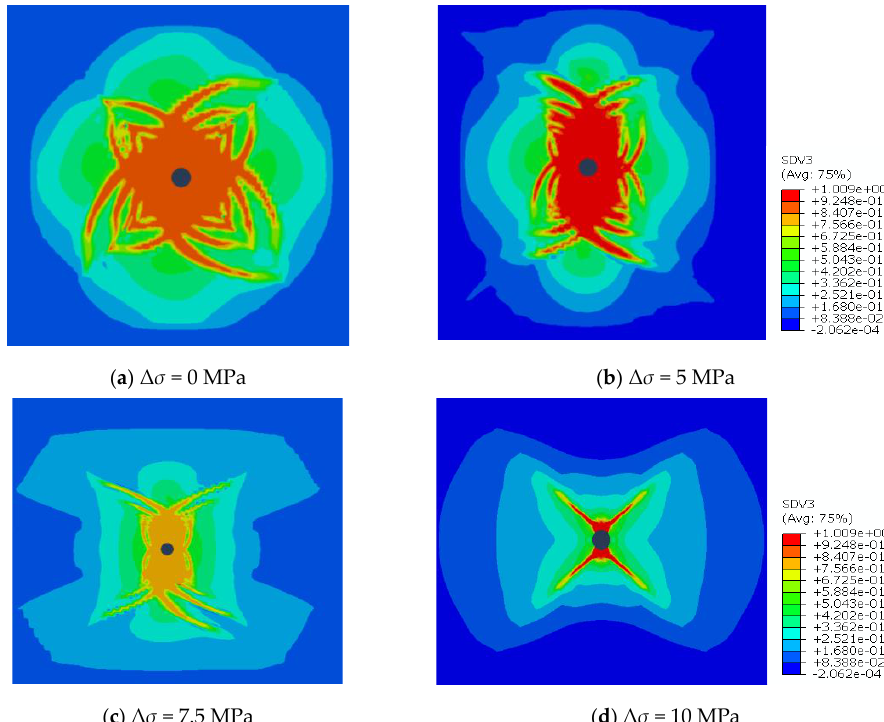
Figure 7. Evolution of disturbance damage factor with different stress differences.